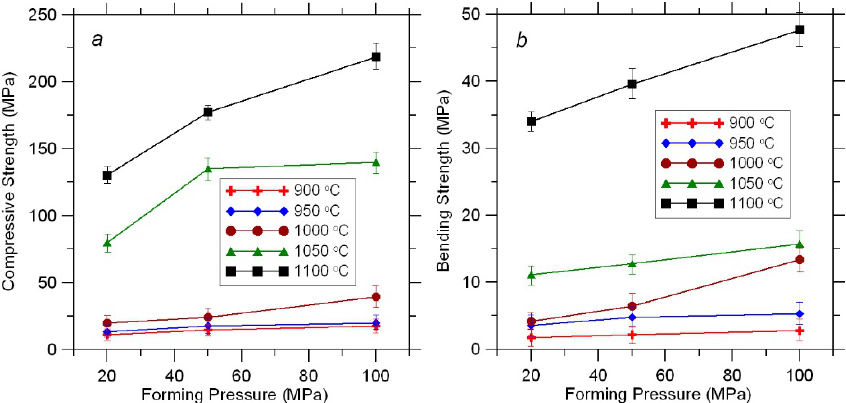
Figure 5. ( a )—Compressive strength versus forming pressure at different firing temperatures. ( b )—Bending strength versus forming pressure at different firing temperatures.